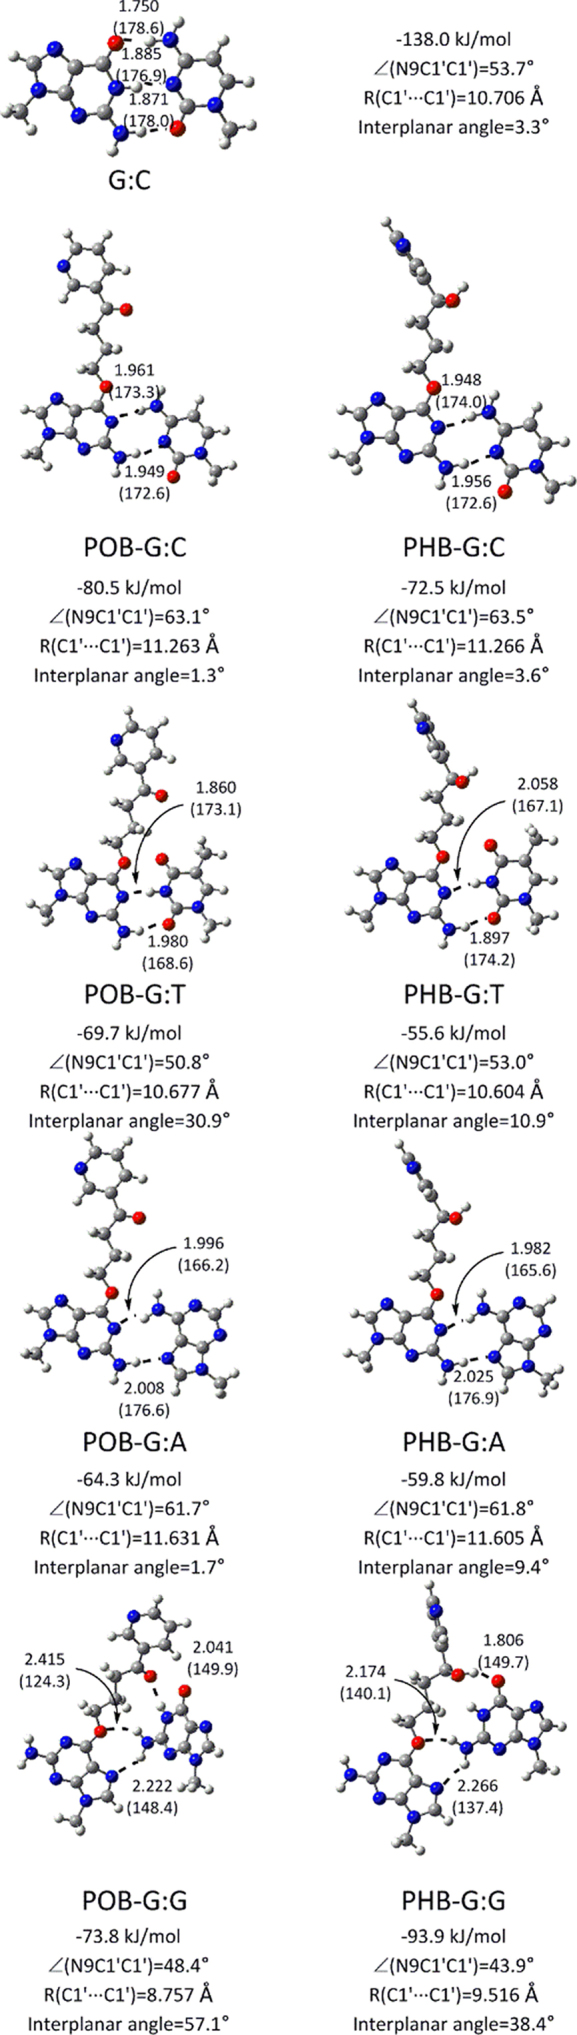
DFT structures (distances in Å and angles in deg.) and binding energies (kJ/mol) for the most stable hydrogen-bonded pairs between the extended POB-G (left) or PHB-G (right) conformation and each canonical nucleobase. Supplementary Figures S5–12 contain data for different lesion orientations. POB-G hydrogen-bonding dimer geometries adapted from reference (31).